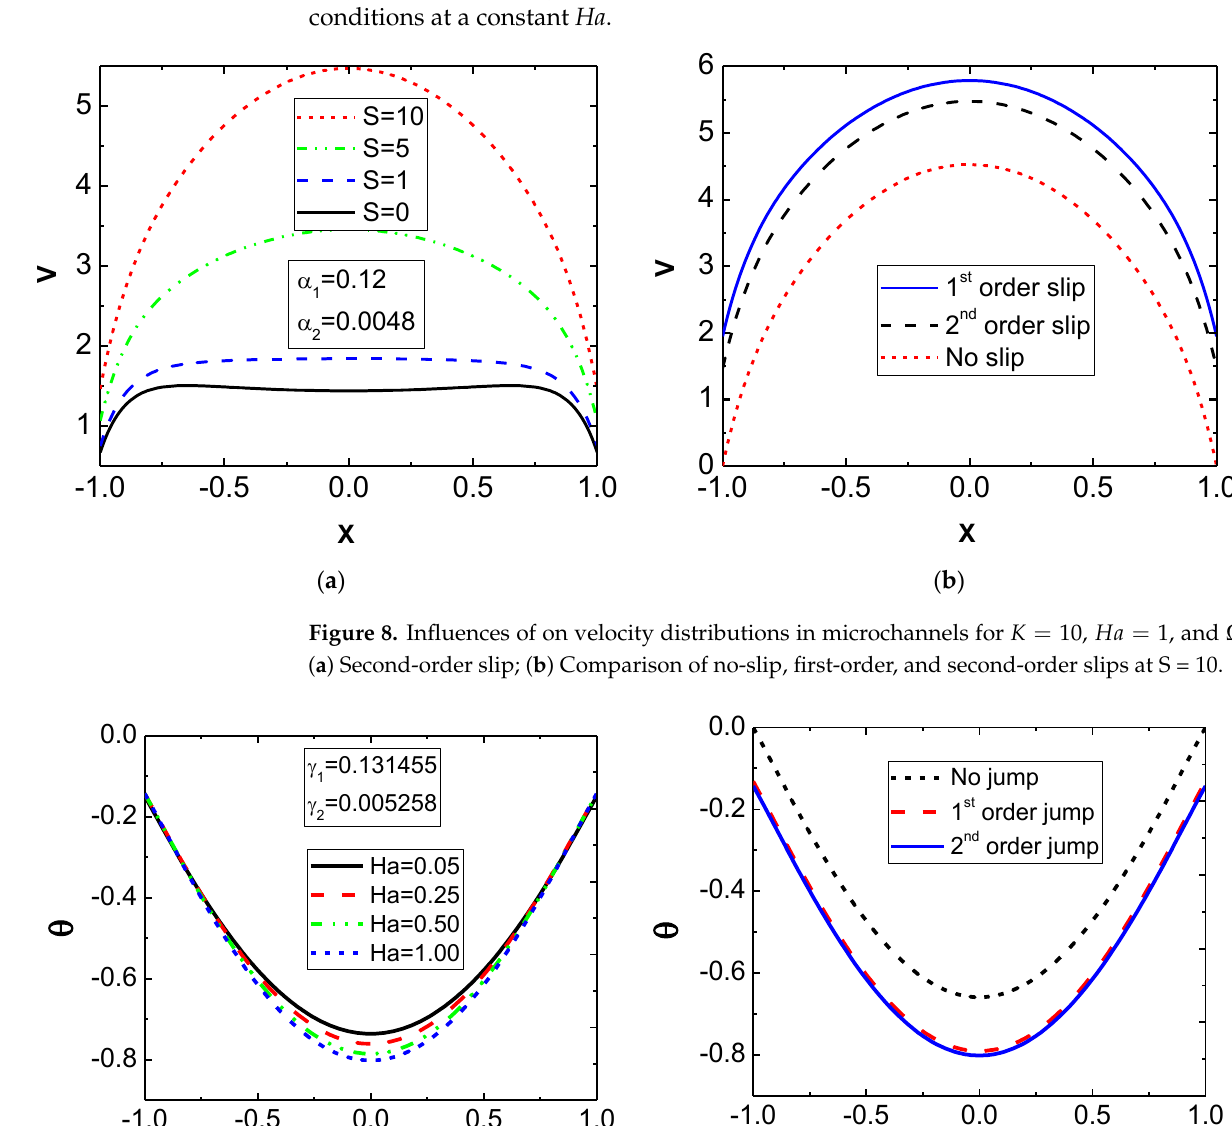
( b ) Figure 10. The temperature distribution in microchannels as a function of Hartmann number at 10 K = ( a ) Second- order jump; ( b ) Comparison of no-jump, first-order jump, and second-order jump at Ha = 8.0. Here, it can be highlighted that the temperature profiles are in the plane of symmetry shown in Figures 8 – 10, and the set of temperature profiles are for the Knudsen number ( Kn ) = 0.08. However, the no-jump boundary condition is taken under the no-slip velocity boundary conditions. The temperature jump exists due to the presence of the Knudsen number stated above. On the other hand, the temperature difference occurs between the wall and fluid for weak thermal communication. Weak thermal communication causes due to a low number of collisions between molecules and walls and molecules themselves. Therefore, a strong temperature gradient creates near the wall. A large temperature gra- dient occurs for the heat transfer near wall surfaces for the first-order and second-order jump (see Figure 2b). For this reason, the temperature difference increases for the